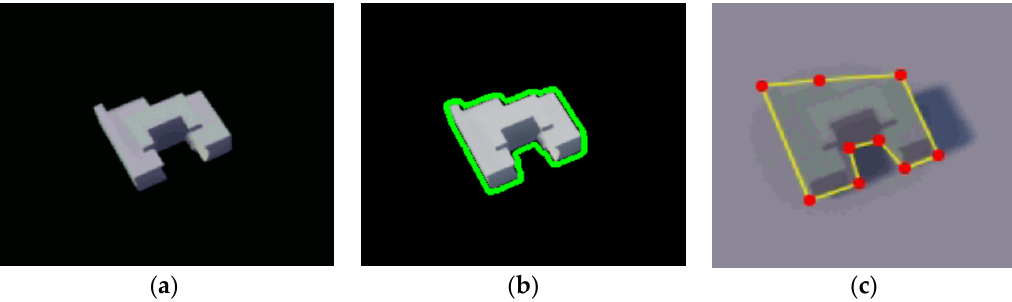
Figure 10. An autogeneration of the part localization by OpenCV for Segmentation: ( a ) the input image with black background from the Unreal Engine; ( b ) the result of OpenCV algorithm for precise contour generation; ( c ) an example of manual contour selection in VGG Image Annotator.